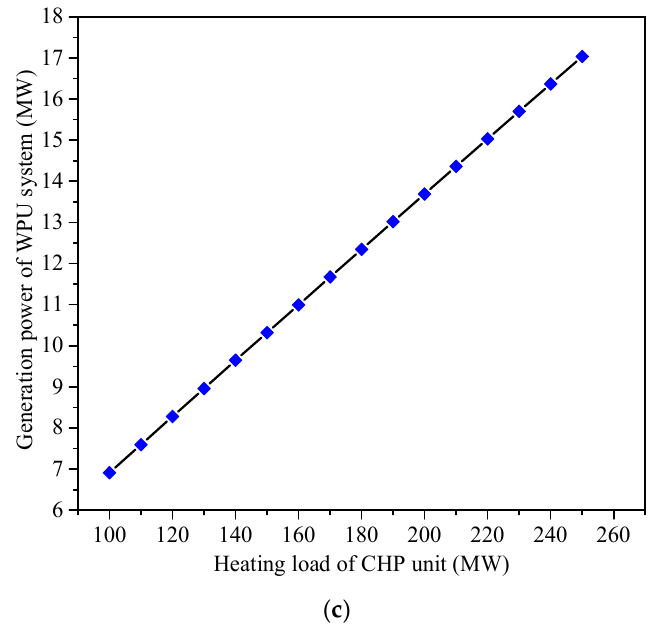
Figure 11. Effect of the unit heating load on the thermal performances of the original and improved CHP units (the unit generation load was set as 250 MW, and the supply and return-water temperatures were set as 95 °C and 50 °C). ( a ) Power generation thermal efficiency; ( b ) power generation standard coal consumption rate; and ( c ) generation of power of the WPU system.